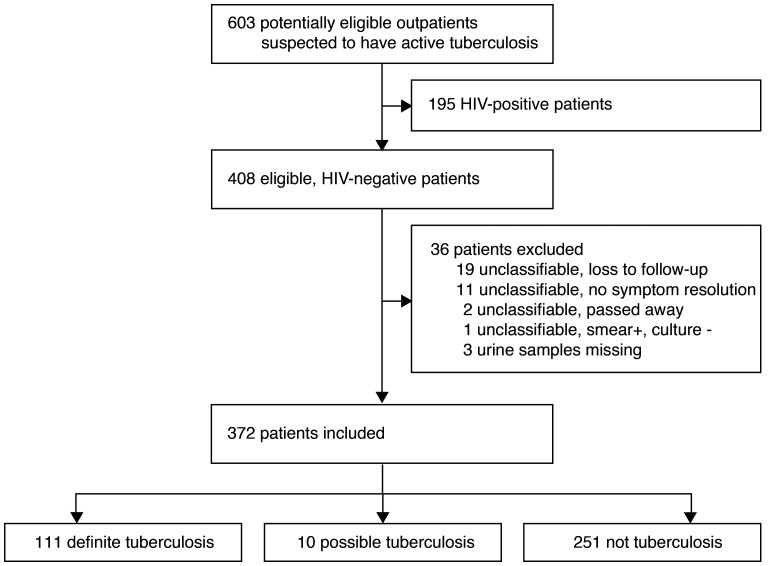
Study flow diagram.